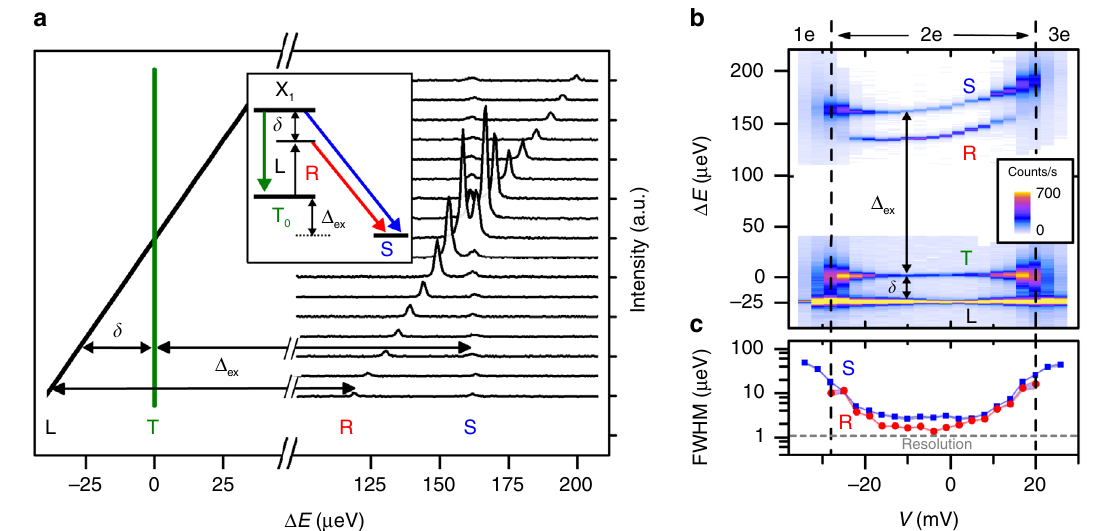
Fig. 2 Spin- fl ip Raman in a QDM. a Emission spectrum of the QDM at a bias of − 10 mV for a series of laser detunings, stepping across the triplet transition. The laser (L) and triplet (T) transition energies are indicated on the left, centered at Δ E = 0, where Δ E is the emission energy minus the triplet transition energy (1307.8 meV). The inset energy-level diagram illustrates the Raman (R), singlet PL (S), and triplet PL (T). b Emission spectrum colormap as a function of bias and Δ E , with δ = − 25 µ eV. c Linewidth of R and S as a function of